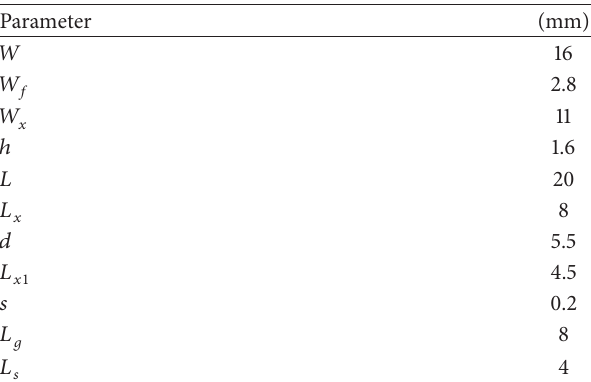
Table 1: Parameters of the proposed notched